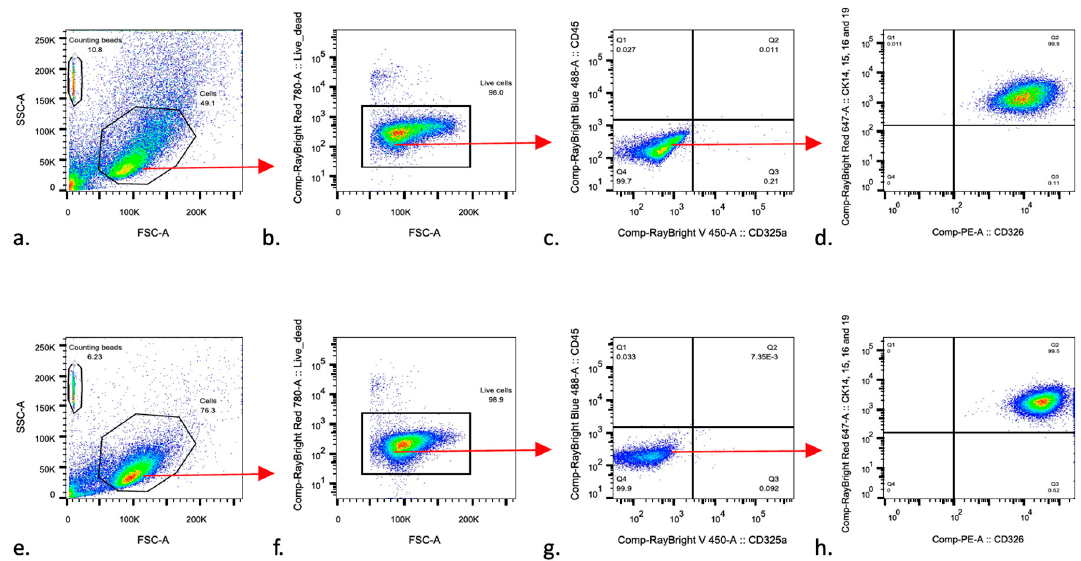
Figure 3. Urine-derived cells express epithelial cell surface markers. Fluorescence-activated cell sorting analysis of urine-derived epithelial cells at P1 from Case 1 (top panel, a – d ) and Case 3 (bottom panel, e – h ). Cells were stained with antibodies against epithelial surface markers pan-cytokeratin (CK14, CK15, CK16, CK19) and CD326. In addition, cells were stained with antibodies to general hematopoietic cell marker CD45 (RayBright 488) and a marker for the human erythroid cells and their progenitors CD235a (BV421). From left to right, the cells were separated from precipitation and debris by gating them for further analyses (as shown by the red arrow). Only alive cells ( b , f corresponding to 98% and 98.8% of alive cells, respectively) were included in the analysis. The cells stained negative for CD45 and CD325a ( c , g ) while stained strongly positive for the CD326, CK14, CK15, CK16, and CK19 ( d , h ).